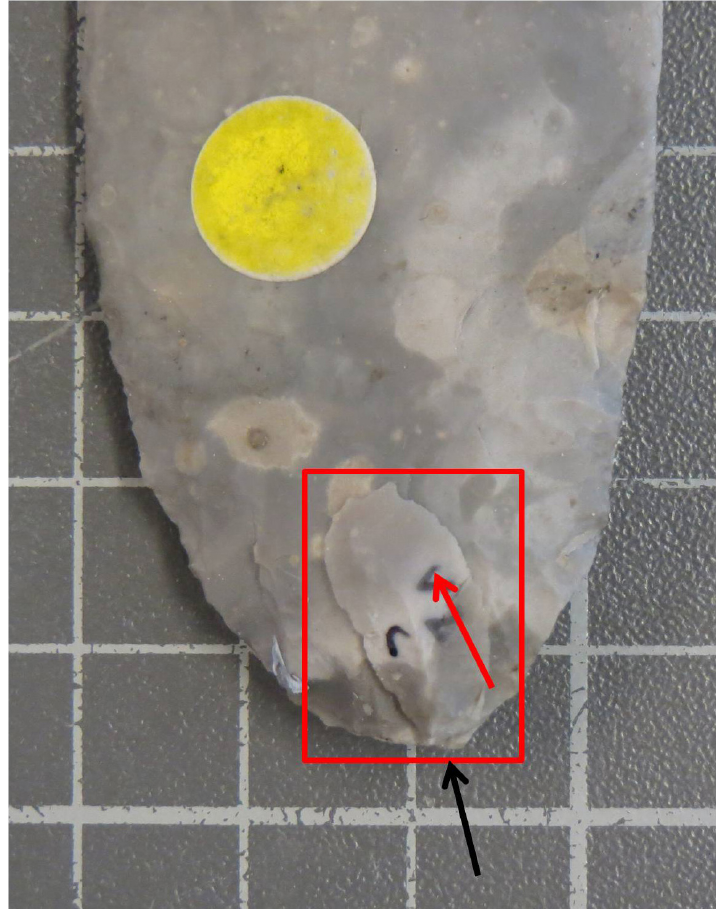
Figure 9. Blade-point 4.2, flake v2c with the black arrow showing direction of removal blow and the red arrow the direction of an earlier removal on the dorsal right (photograph by the author). Gridlines on this image are 10mm